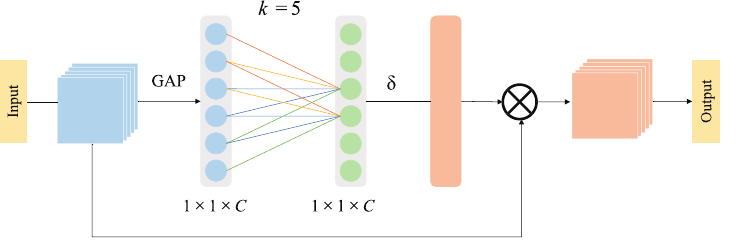
Figure 5. Adaptive Channel Attention